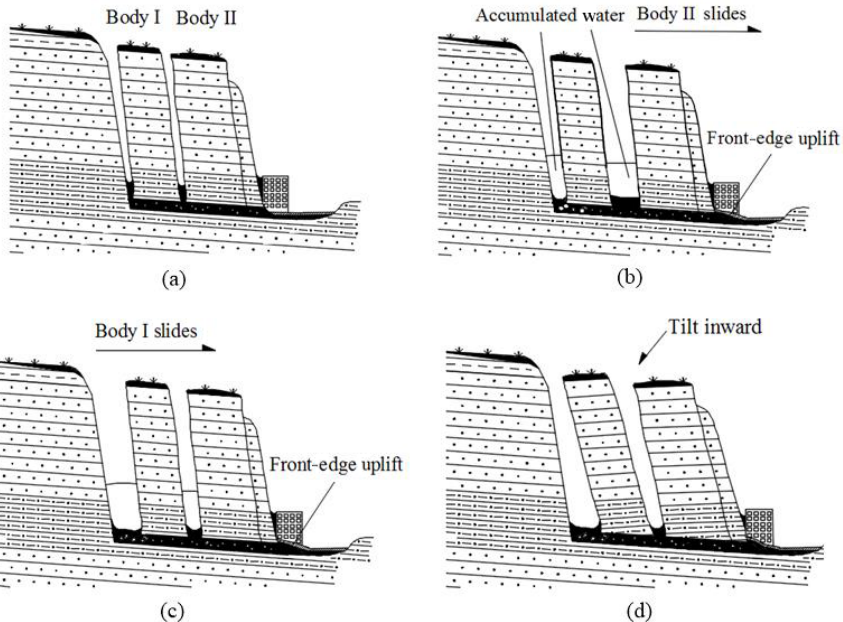
Figure 12. Schematic drawing of the deformation and failure mode of the Wobaoshi landslide: (a) the initial state of bodies I and II, (b) body II sliding firstly in rainy season, (c) body I sliding after body II, and (d) bodies I and II tilting inward in dry